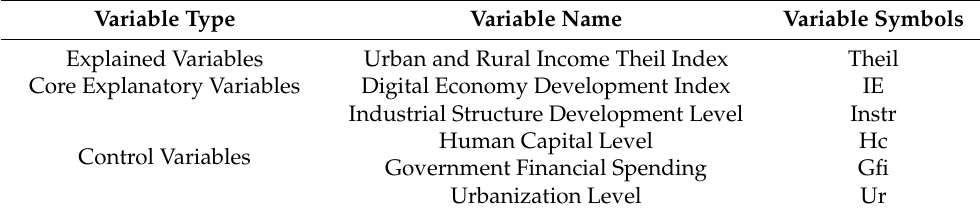
Table 1. Variable